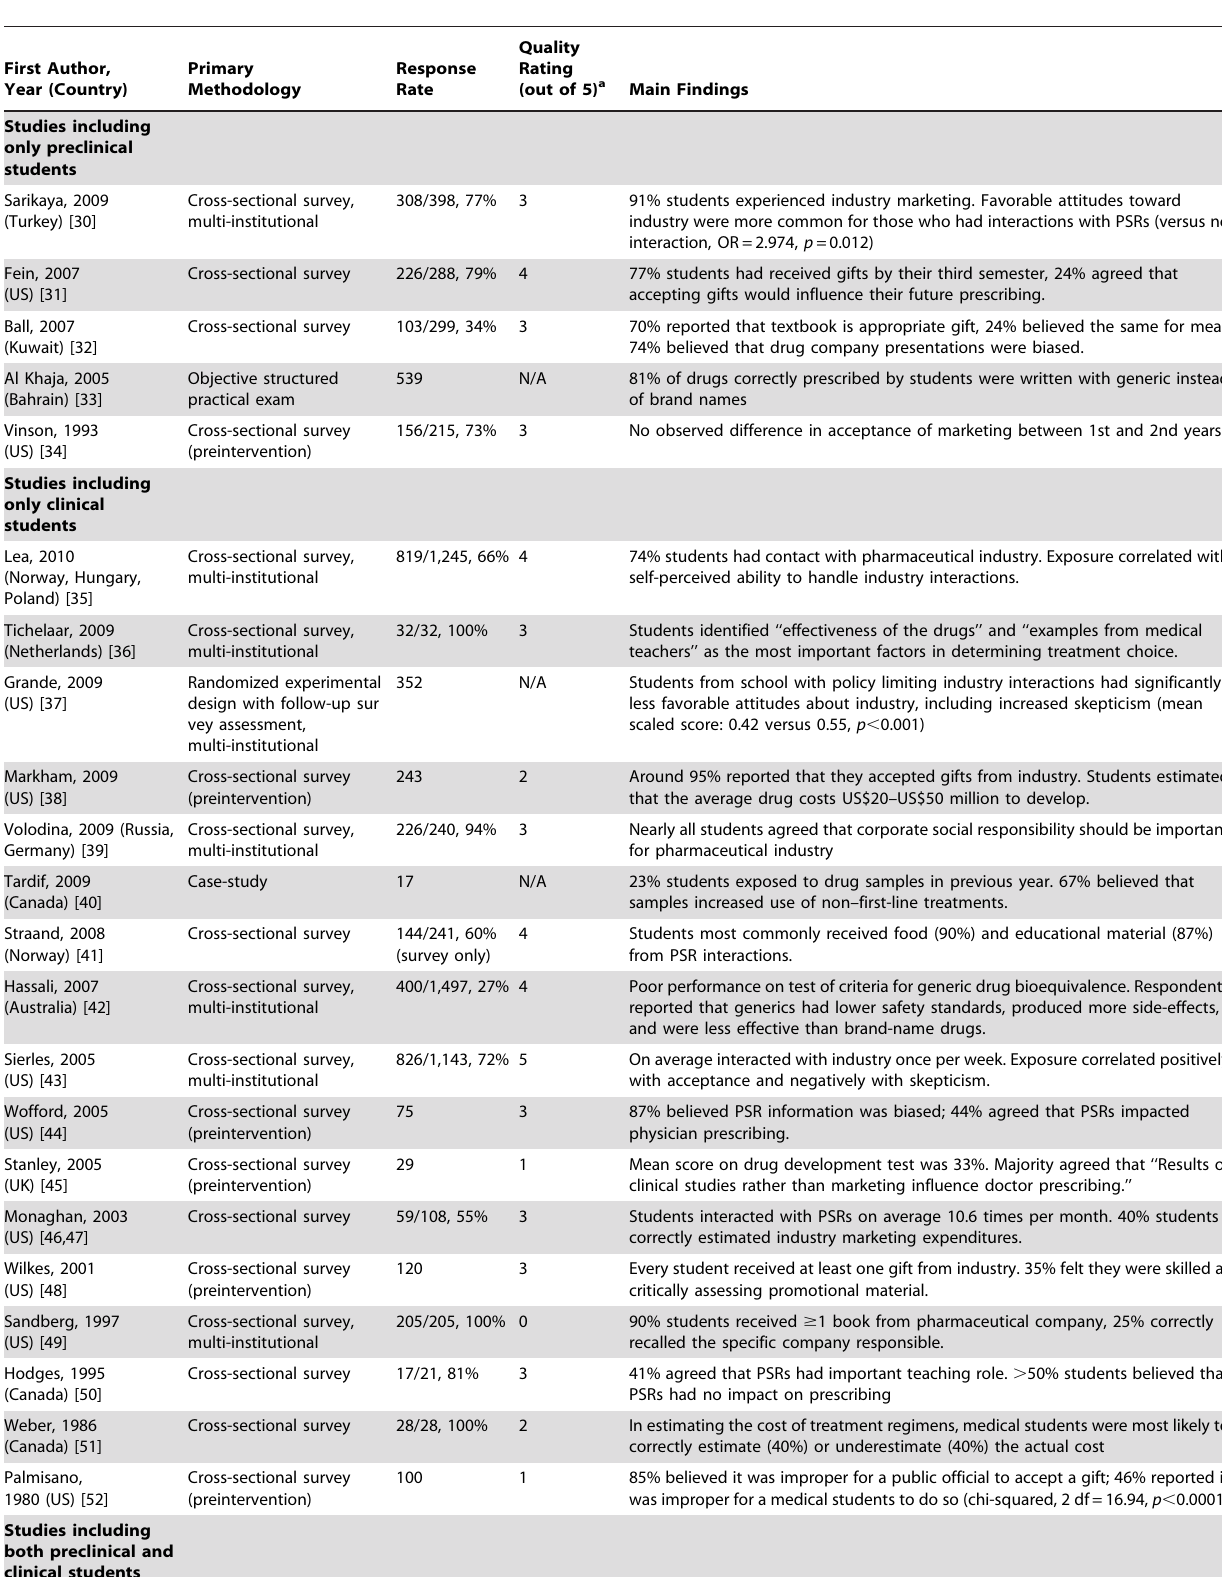
Table 1. Empirical studies of medical students’ attitudes about and exposures to pharmaceutical industry included in the systematic